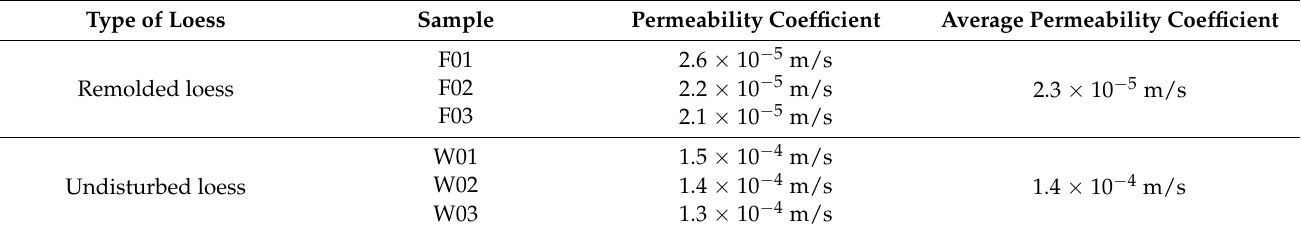
Figure 13. VWC on both sides of the boundary (the blue line is VWC in the original mountain, and the red line is VWC in the filling area). Table 5. Permeability coefficients of undisturbed loess and remolded